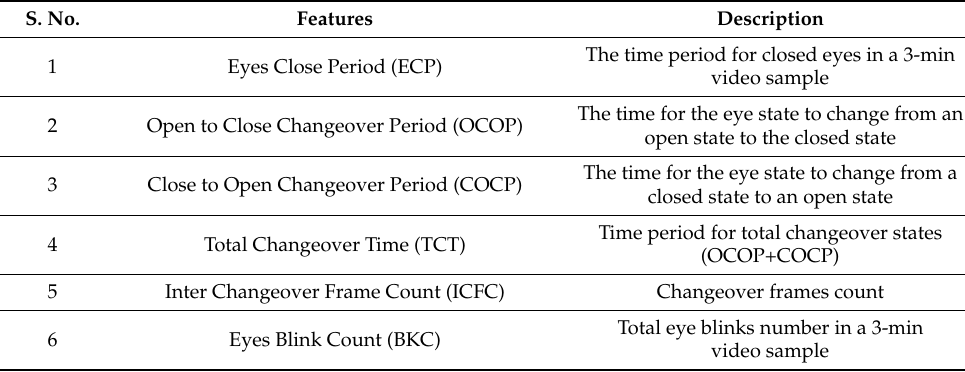
Table 1. List of features from visual spectra facial image. S. No.